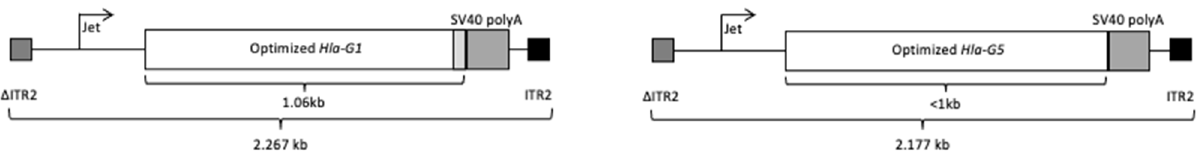
Figure 3. Diagram of the self-complementary scAAV8G9-optHLA-G vector cassette (From Hirsch MH, et al. Sci Report s 2017; 7;